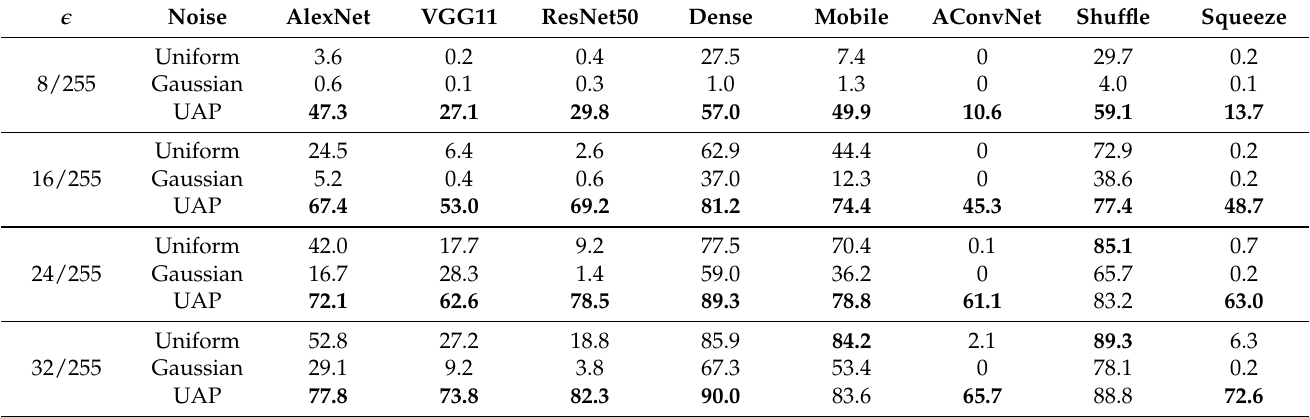
Table 4. Fooling ratio (%) of CosSim-UAP with substitute model of MobileNetV2 and various (cid:101) . The deviation of Gaussian noise is set to (cid:101) /3, and the results of random noise are averaged on 10 runs. Best results are highlighted in Bold. Results of DF-UAP and GD-UAP can be found in Tables A1 and A2.